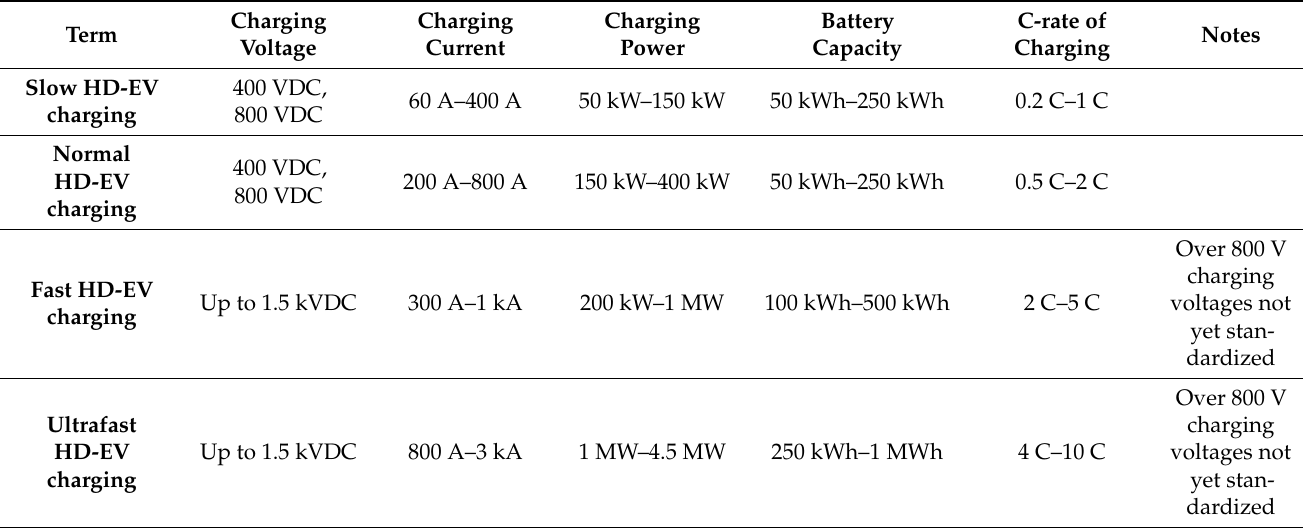
Table 9. Terminology for HDV conductive charging and related C-rates. The values are typical, and they may